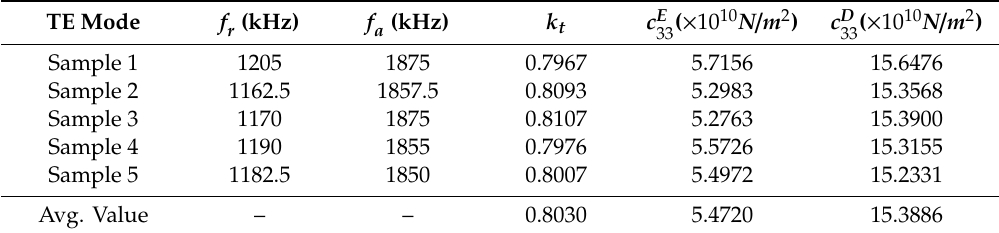
Table 2. Resonant and anti-resonant frequencies and the converted material constants in thickness extension (TE) mode.